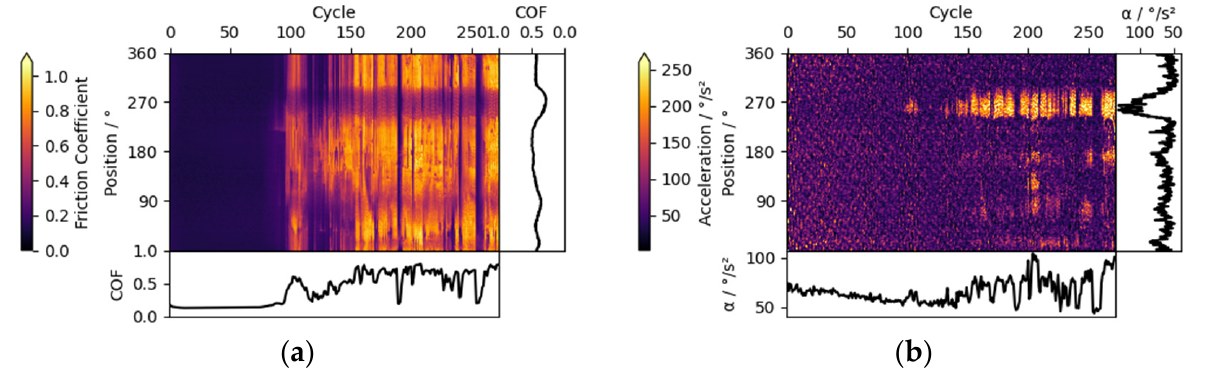
Figure 6. Triboscopic images for a ta-C 3 coating vs. a Cu counter body in 4 ∙ 10 − 7 mbar vacuum, showing regions of stick-slip at position 270°, starting at cycle 100; ( a ) friction triboscopic image; ( b ) acceleration triboscopic image.